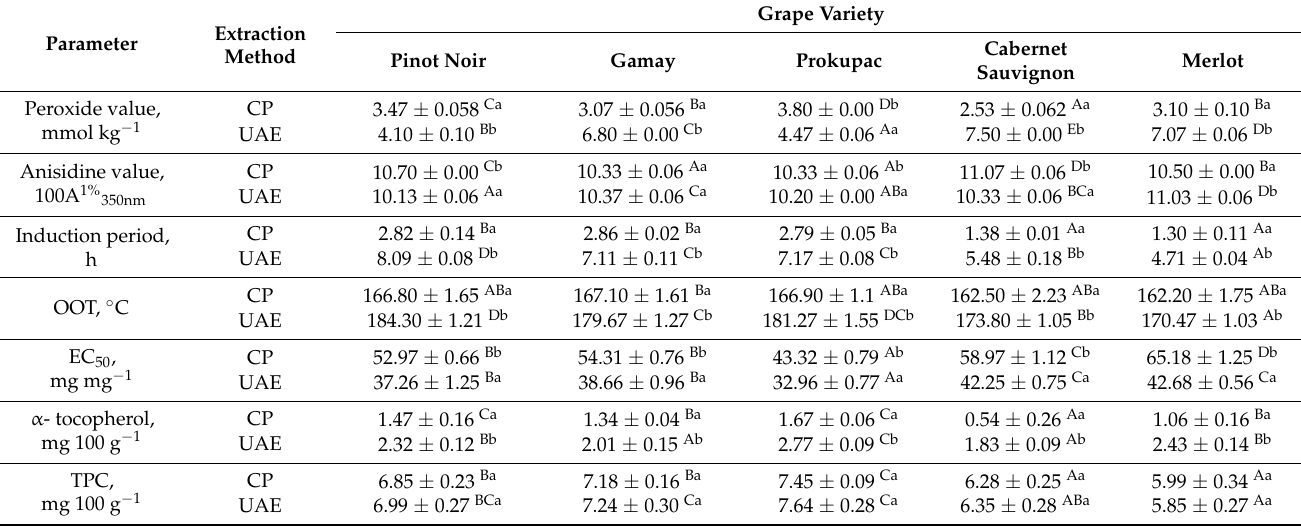
Table 3. Parameters of oxidative status and antioxidative capacity of